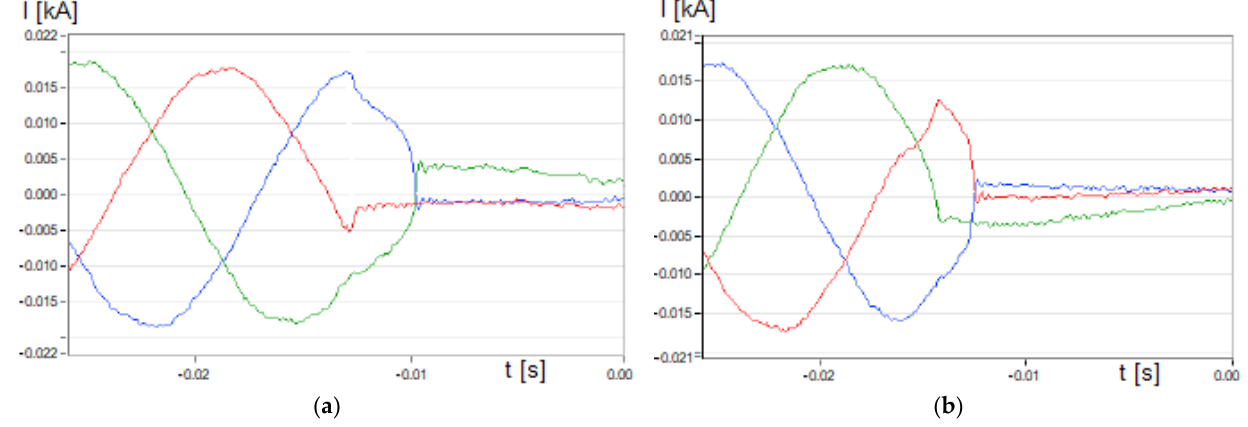
Figure 6. Measurement results ( a ) Vacuum circuit breaker (VCB); ( b ) Oil circuit breaker (Oil CB).